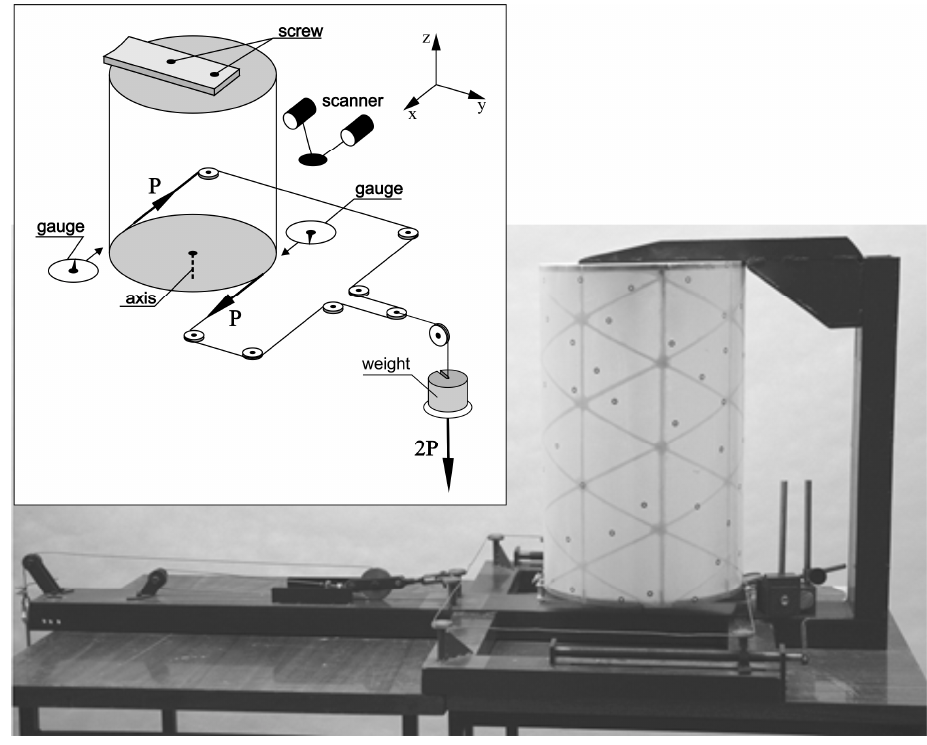
Figure 3. Stand for experimental research, load and deformation measurement diagram.